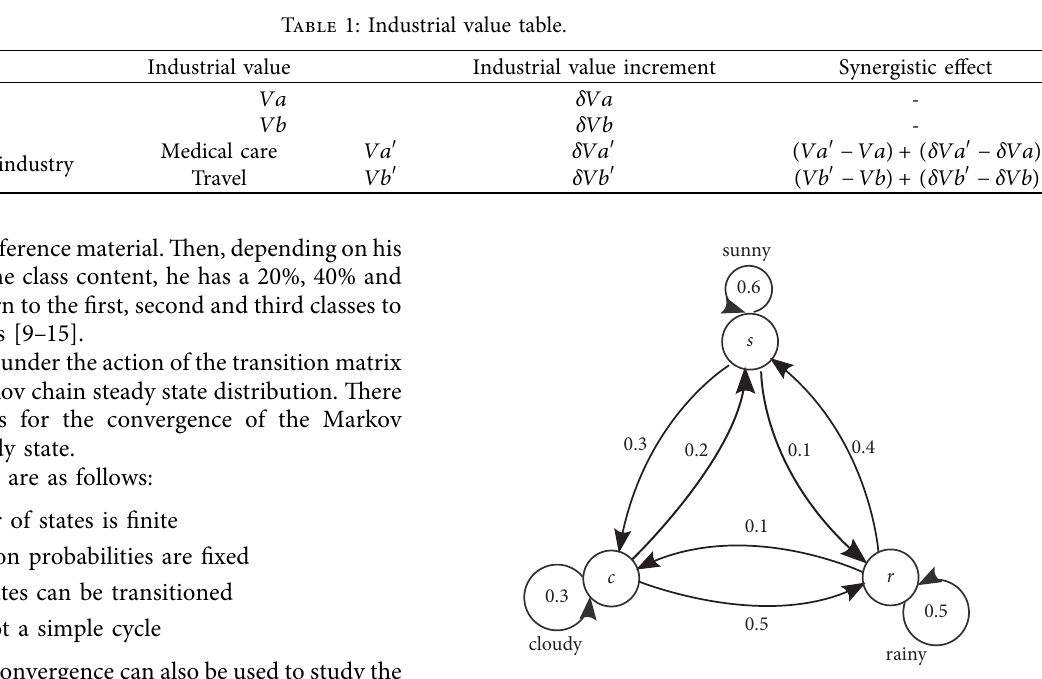
Figure 2: Markov usage